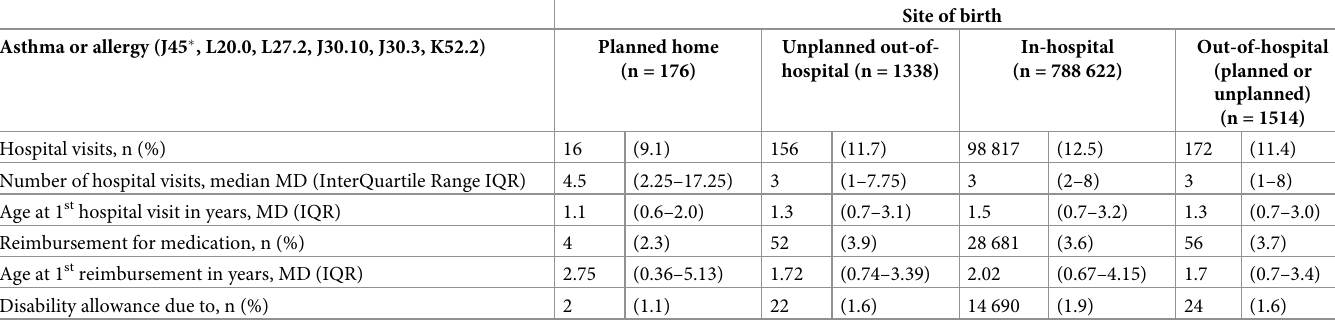
Table 3. Morbidity related to asthma or allergy (n = 790 316).